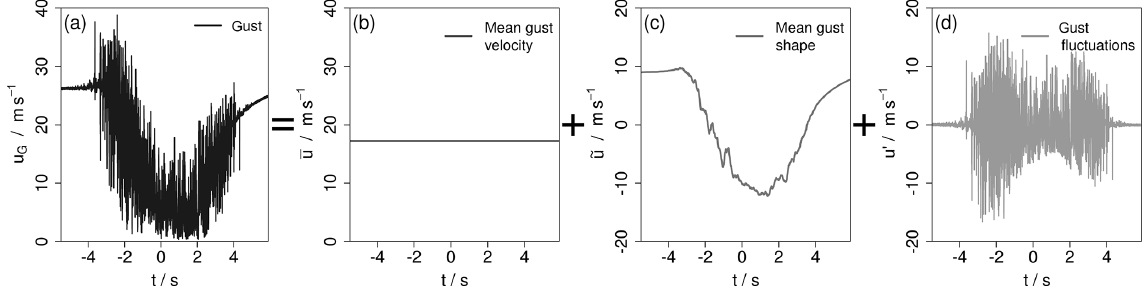
Figure 5. Example of a triple decomposition of the inverse gust u G = u + ˜ u + u (cid:48) (a) into its mean velocity u (b) , the underlying inverse gust shape ˜ u (c) , and the fluctuations u (cid:48) (d)